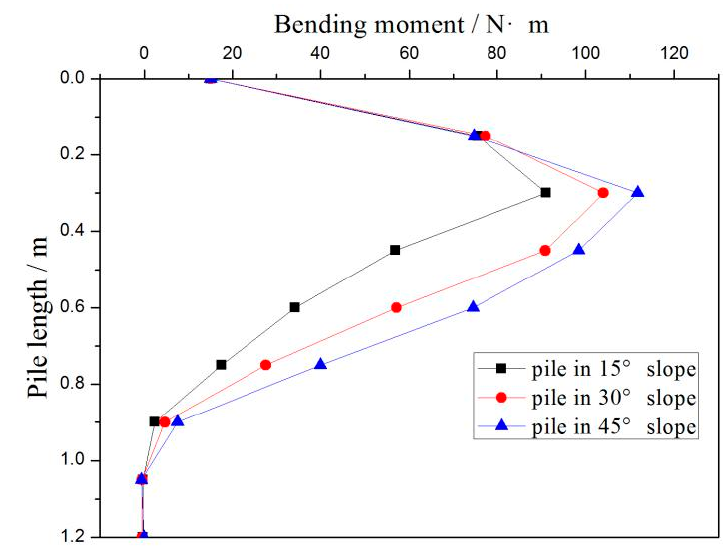
Figure 10. The bending moments of piles with different slope angles.